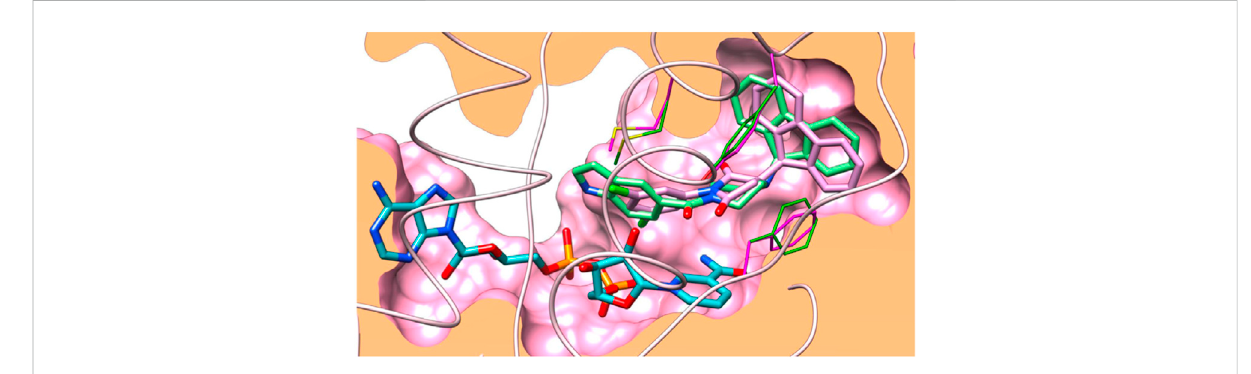
FIGURE 2 Docking binding of 6b with InhA. Reproduced from Baltas et al., 2013, with permission from Elsevier, Copyright 2013.